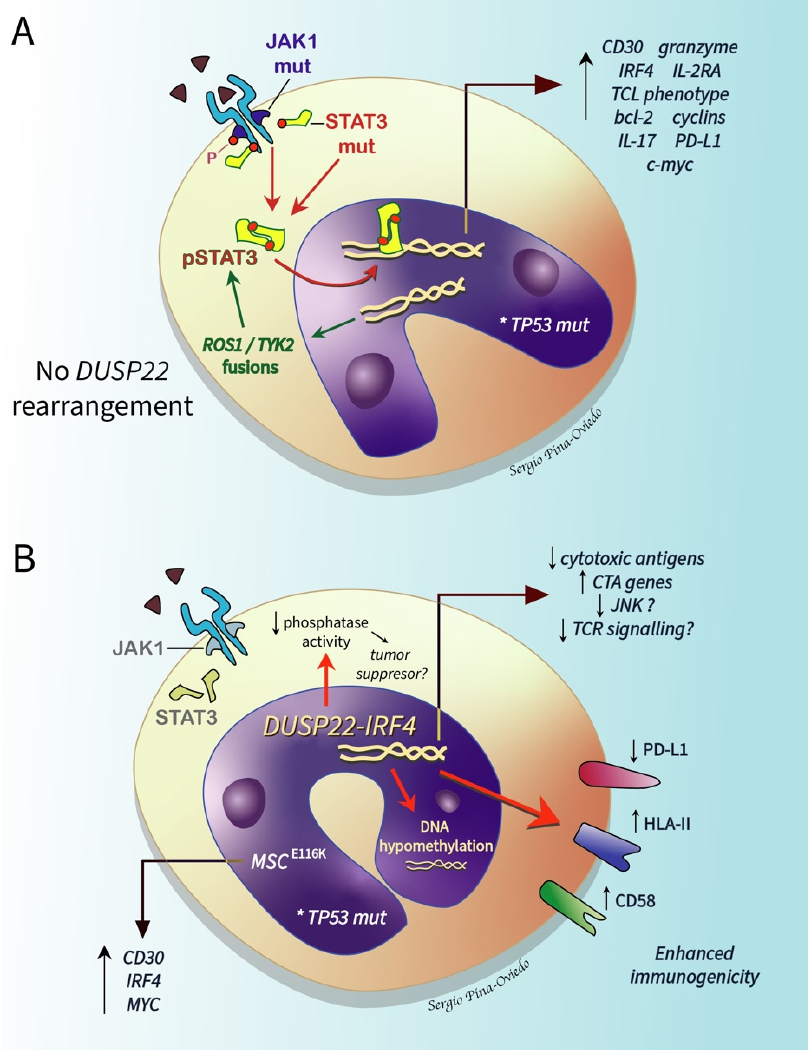
Figure 9. Molecular pathogenesis of systemic ALK- ALCL. ( A ) Mutations (mut) of JAK1 and/or STAT3 as well as the co-mutation of JAK and STAT have been implicated in the pathogenesis of this lymphoma. These mutations result in the constitutive activation of STAT (phosphorylated STAT; pSTAT3) that translocates to the nucleus and induces multiple genes resulting in the expression/activation of the molecules listed and of a T-cell lymphoma (TCL) phenotype Additionally, chimeric fusion genes with concomitant transcriptional and kinase activity ( ROS1 , TYK2 ) are also capable of sustaining the ALCL phenotype via pSTAT3. The activation of the JAK/STAT pathway is only found in cases without the DUSP22 rearrangement. ( B ) ALK- ALCL with DUSP22-IRF4 rearrangement/t(6;7)(p25.3;q32.3) is associated with downregulation of DUSP22 (dual specificity phosphatase 22) and likely its decreased phosphatase activity that may result in tumor suppressor effects that are yet unknown. The DUSP22-IRF4 rearrangement has been associated with a decreased expression of cytotoxic molecules, marked DNA hypomethylation, and an enhanced immunogenicity via the overexpression of immunogenic cancer-testis antigen (CTA) genes, HLA class II and CD58, and the downregulation of PD-L1. These mechanisms may contribute to the favorable prognosis seen in this group of ALK- ALCLs. Most DUSP22 -rearranged cases also harbor a recurrent mutation in musculin ( MSC E116K ) that induces the expression of the CD30–IRF4–MYC axis. In vitro studies have shown that DUSP22 has the capacity to suppress TCR-induced activation/signaling and JNK signaling that could also have an effect on the pathogenesis of this lymphoma. In both scenarios, the presence or acquisition of a TP53 mutation (*) confers a bad prognosis.